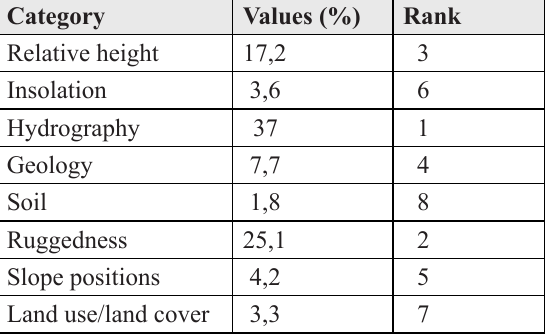
Table 3. Geomorphological factor ranking values